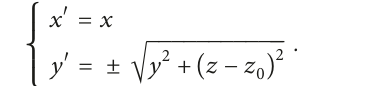
Figure 2: Definition of horizontal, vertical, and oblique straight line